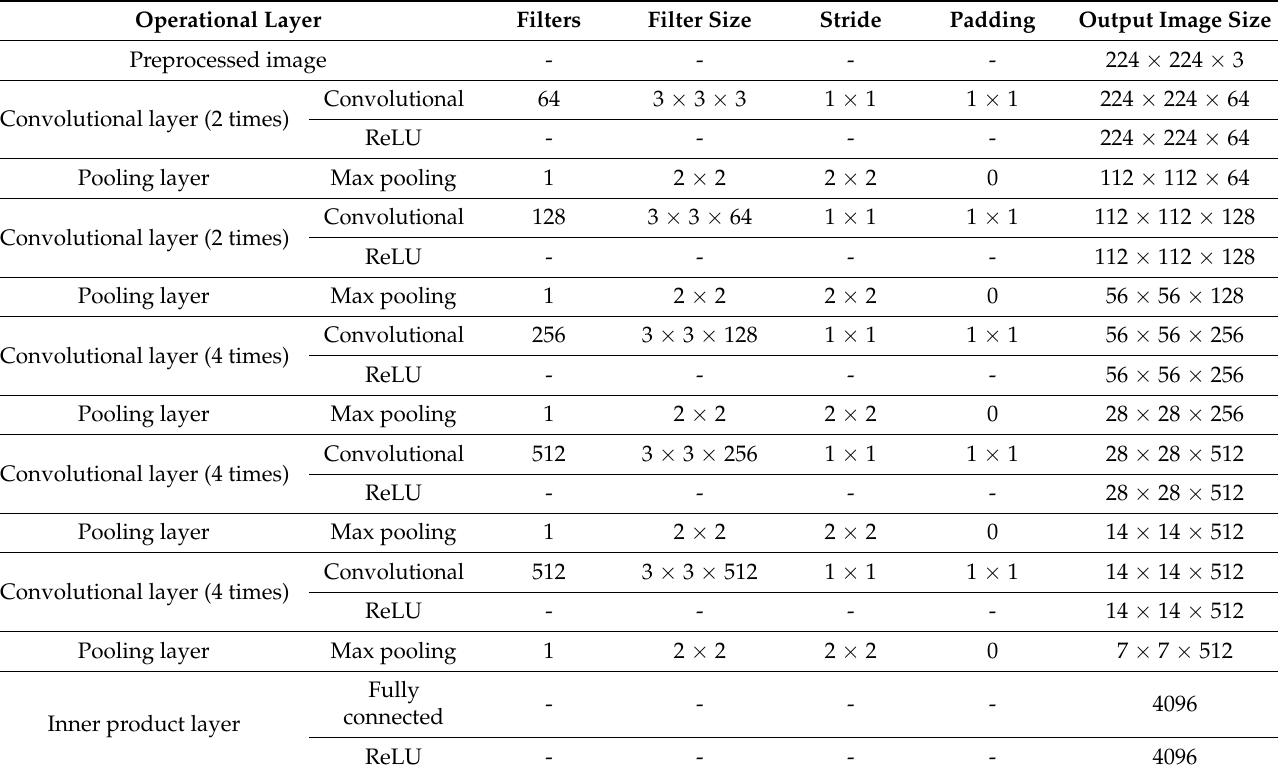
Table 1. Layers of the convolutional neural